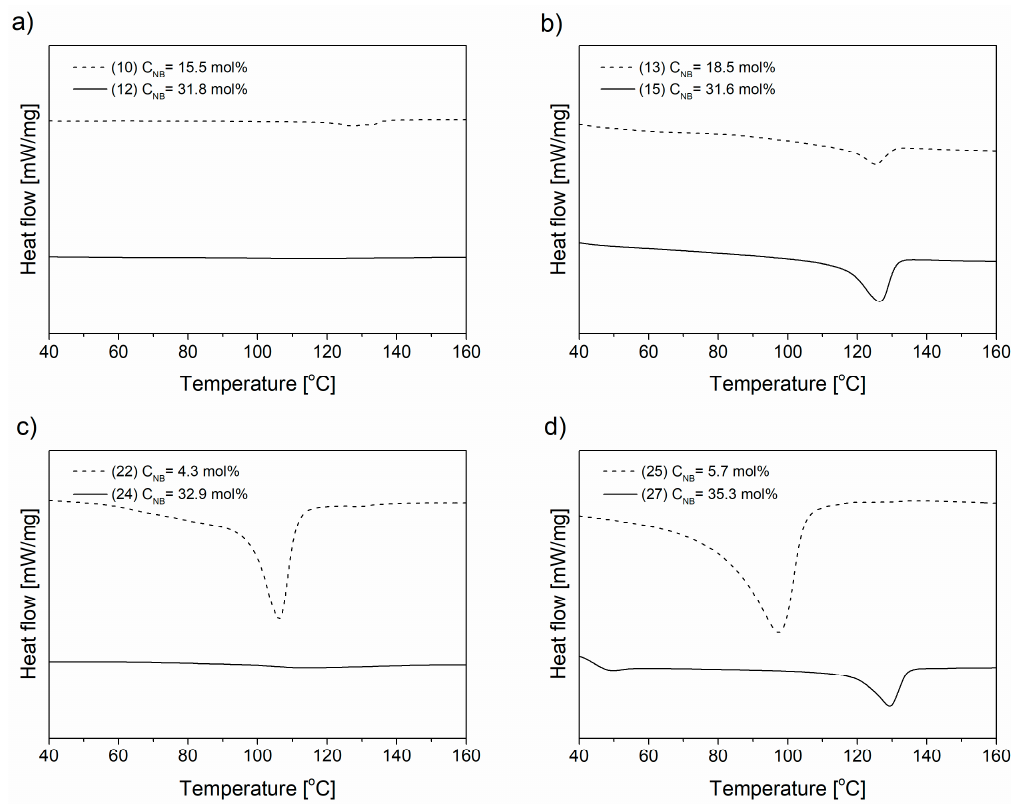
Figure 5. The endothermic curves of E-NB copolymers obtained by C4 ( a ), SIL/C4 ( b ), C6 ( c ), SIL/C6 ( d ) complex (items according to Table 1).